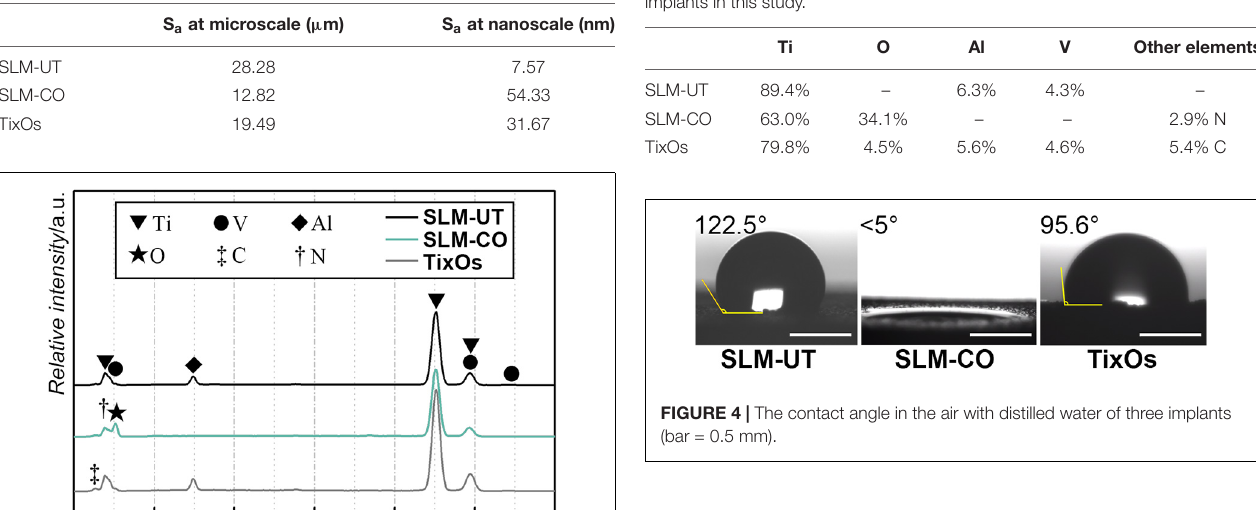
TABLE 2 | The S a at micro and nano scale of three implants in this study.